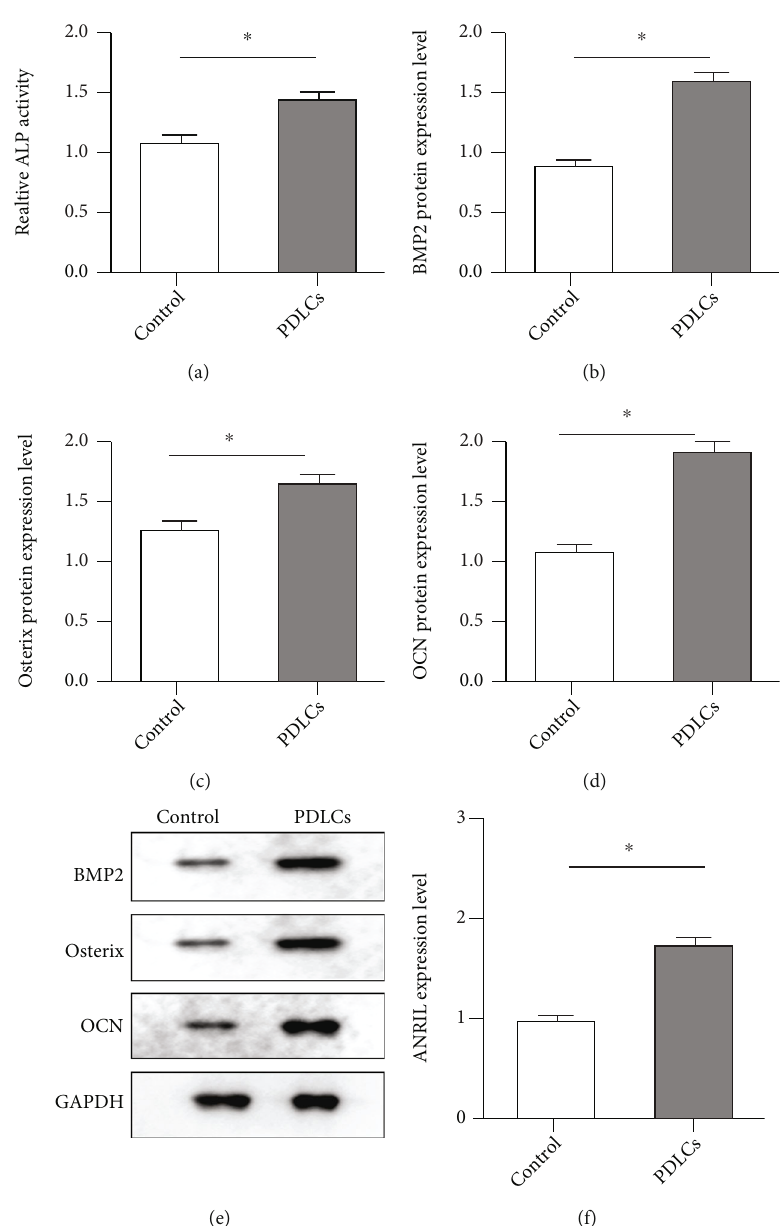
Figure 2: Identi fi cation of osteogenic di ff erentiation model. (a) ALP activity was detected in undi ff erentiated and di ff erentiated PDLCs. The relative protein expression normalized to GAPDH was calculated, including (b) BMP2, (c) Osterix, and (d) OCN. (e) The protein levels of osteogenic-related markers as BMP2, Osterix, and OCN were tested by Western blot. GAPDH was performed as the housekeeping control. (f) The expression of ANRIL was measured in undi ff erentiated and di ff erentiated PDLCs by qPCR. ∗ P < 0 : 05